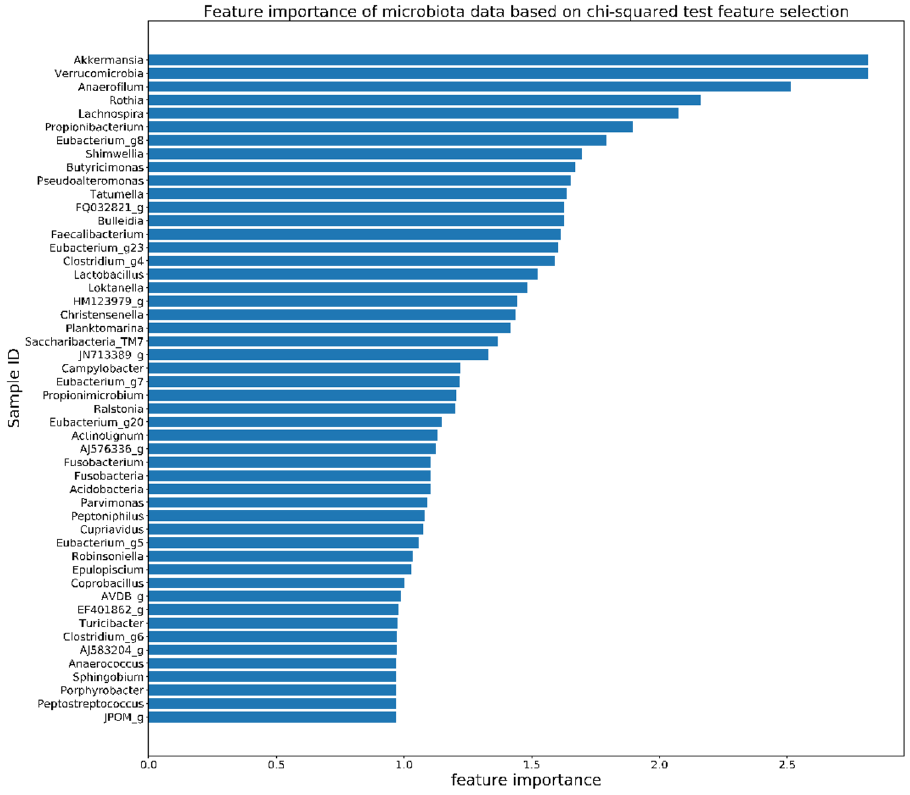
Figure 5. The average feature importance of the top 50 selected microorganisms from the microbiota